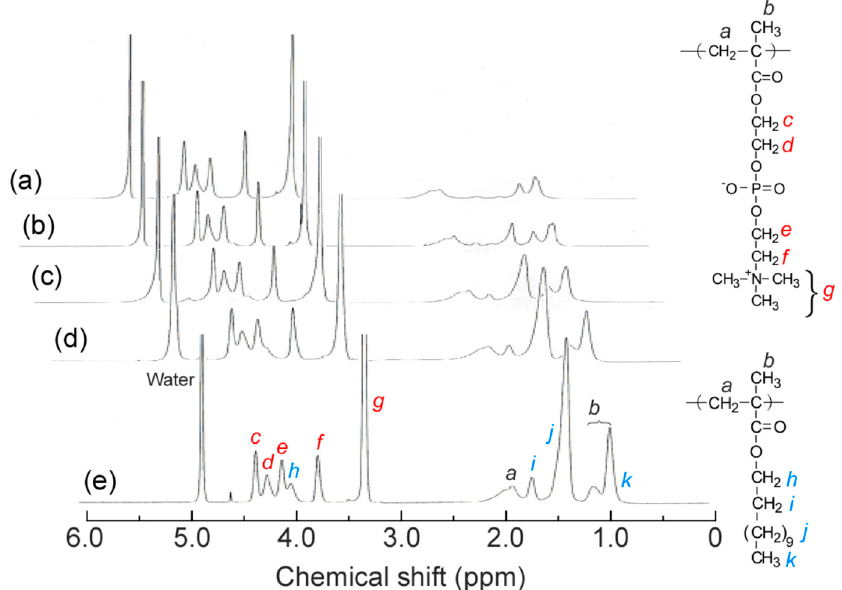
Figure 2. 1 H NMR spectra for P(MPC/DMA x ) in methanol- d 4 : x = 0 ( a ), 10 ( b ), 19 ( c ), 28 ( d ), and 38 mol % ( e ).